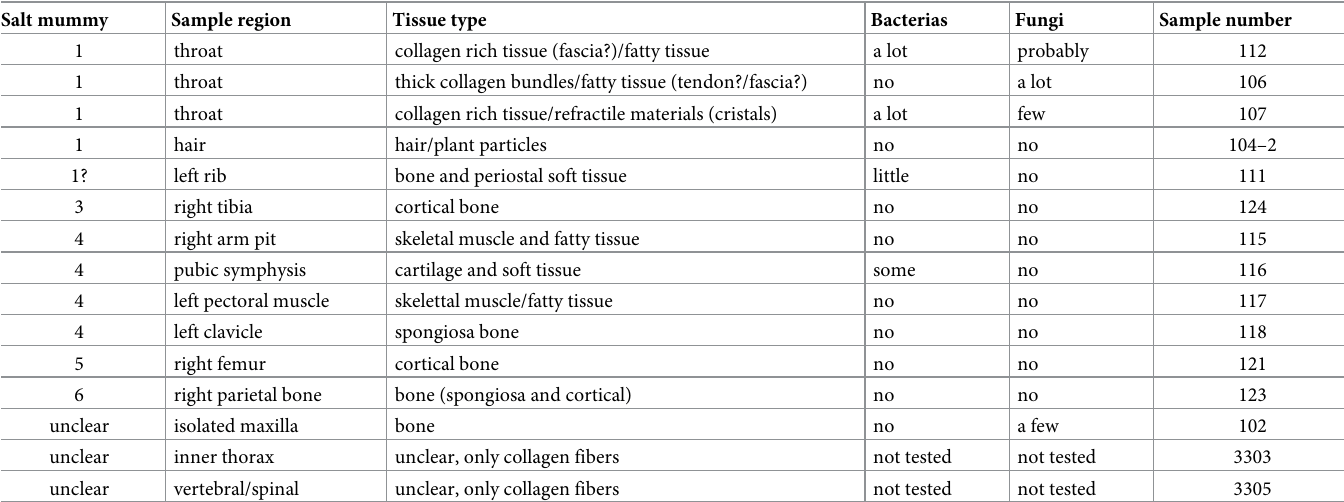
Table 1. Overview of the histology